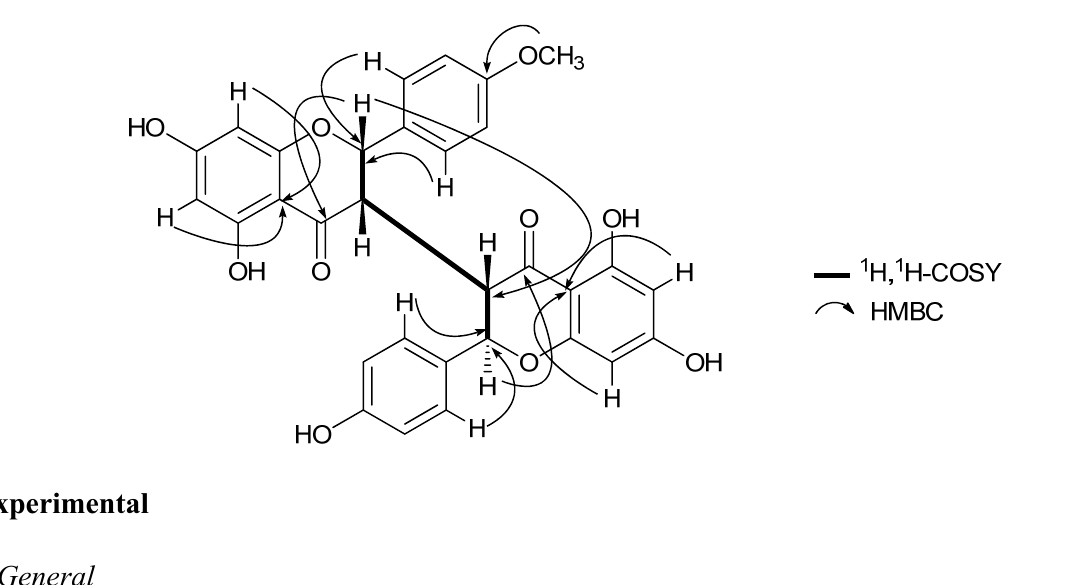
Figure 2. Key 1 H- 1 H COSY and HMBC correlations of 1